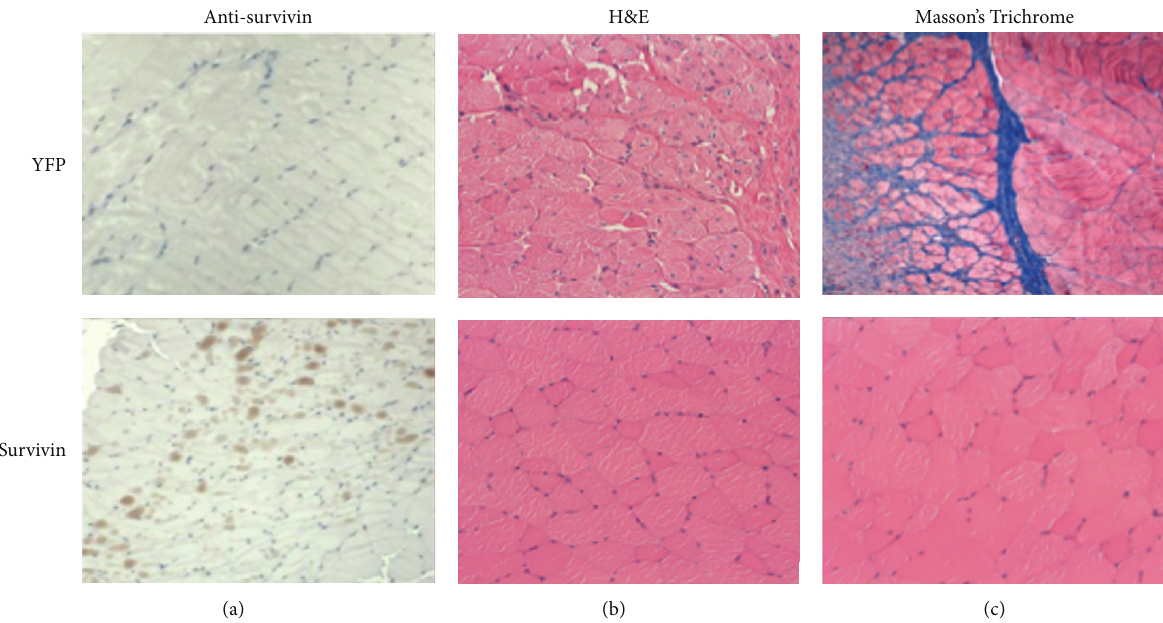
Figure 4: Histological analysis shows that survivin expression can mitigate the damaging effects of radiation therapy at the cellular level. After six weeks, mice were euthanized and muscle as well as the overlying dermal tissue at the site of radiation treatment was excised, stained, and examined. Mice treated with rAAV-survivin showed increased expression of the survivin protein (a). H&E staining showed that the integrity of the tissue was significantly affected at the cellular level in YFP mice but not in survivin expressing mice (b). Additionally, fibrosis was evident in the YFP mice but not in the survivin mice, as shown by staining with Masson’s Trichrome